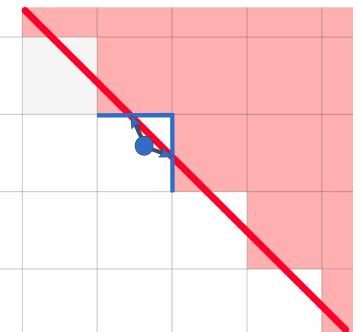
Figure 4. Sketch to illustrate the mapping of a wall surface obser- vation point to a gridded step-wise approximation of the wall. The red line represents the real wall surface, light grey lines delineate the grid cells, the light red area shows the footprint of the gridded building, the blue circle shows the surface evaluation point, and the blue arrows represent the assignment of this point to the grid faces (blue lines) used for the calculation of the corresponding modelled